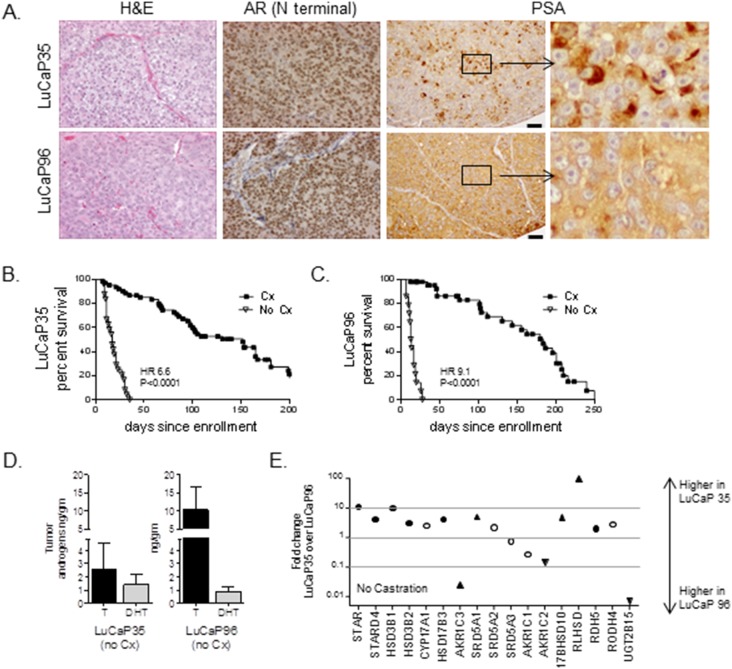
Characterization of LuCaP35 and LuCaP96 prostate cancer xenografts and responses to systemic androgen suppression.(A) Representative FFPE samples of each xenograft were stained with hematoxylin and eosin (H&E) and for expression of the androgen receptor (AR) and PSA as indicated. The scale bar (depicted on the PSA figures for ease of visualization) are 50µm. Kaplan-Meier plots of progression free survival (defined as tumor size <750 mm3) in mice bearing LuCaP35 (B) or LuCaP96 (C) xenografts. Intact male SCID mice were implanted subcutaneously with 30 mm3 pieces of the indicated xenografts. When tumors reached ∼300 mm3, mice were randomly enrolled into cohorts that were either left intact (No Cx) or castrated (Cx). P-values for curve comparisons were generated using the Mantel-Haenszel logrank test. (D) Mean and standard deviation of tissue testosterone (T, black bar) and DHT (gray bar) levels measured by mass spectrometry in tumors of the indicated xenograft (passaged in intact mice). (E) Relative expression of transcripts for the indicated steroidogenic genes was calculated using the delta dCt method (fold change = 2∧ddCt). Genes differentially expressed in LuCaP35 vs. LuCaP96 within one order of magnitude are indicated within the gray lines. Significant differences (by Welch’s t test; p<0.05) are indicated by black circles; white circles indicate genes that were not significantly different between LuCaP35 and LuCaP96 (all values given in Supplementary Data 2).Upward triangles indicate highly differentially expressed genes specifically leading to increased T (AKR1C3, 40 fold) or increased DHT levels (SRD5A1, 5.0 fold; 17BHSD10 4.8 fold; RLHSD, 99 fold). Downward triangles indicate highly differentially expressed genes specifically mediating DHT catabolism (AKR1C2, 7 fold; UGT2B15, 3000 fold).